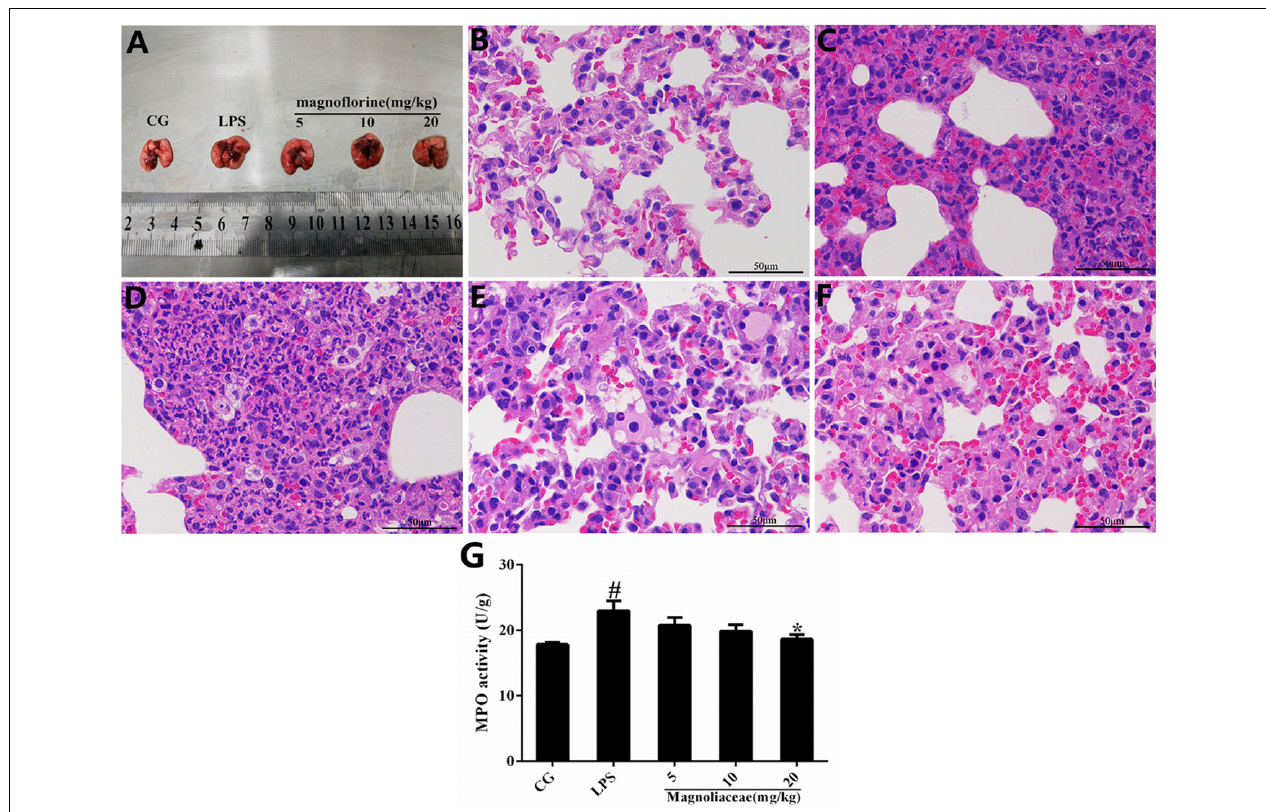
FIGURE 2 | Effects of magnoflorine on LPS-induced lung injury. (A) Morphology of the lung. (B) Control group. (C) LPS group. (D–F) Magnoflorine (5, 10, and 20 mg/kg) groups. (G) . MPO activity assay. CG is the control group. LPS is the LPS-stimulated group. The values are presented as means ± S.E.M. of three independent experiments. ANOVA, p < 0.0001, post hoc # p < 0.05 vs. control group, ∗ p < 0.05 vs. LPS group.